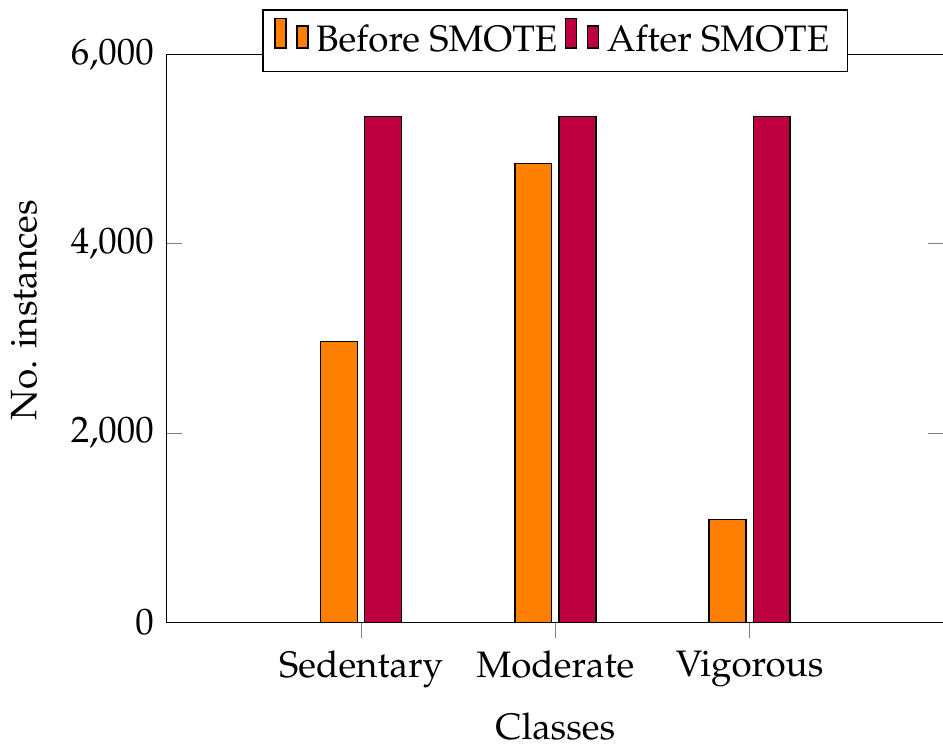
Figure 4. Comparison of no. of instances before and after applying the SMOTE algorithm.